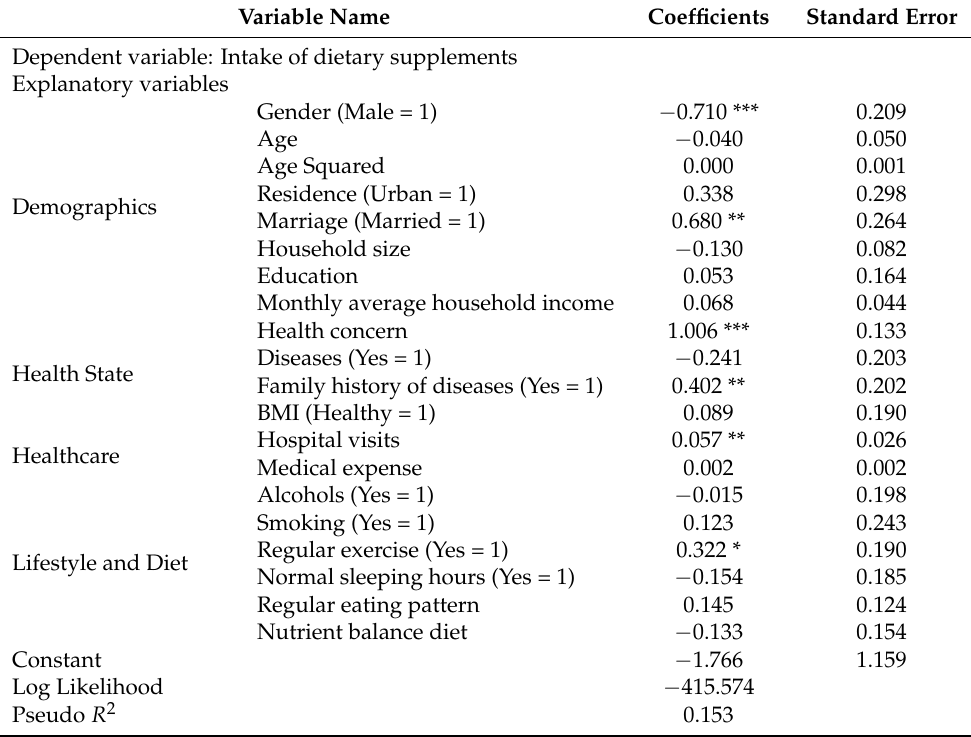
Table 3. Logistic regression results for taking dietary